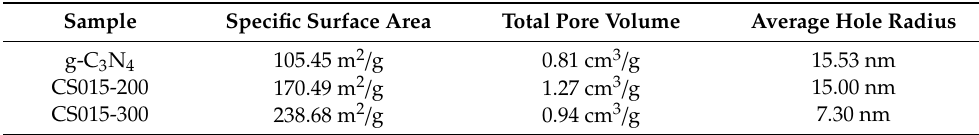
Table 1. The specific surface area, total pore volume, and average hole radius of g-C 3 N 4 , CS015-200 and CS015-300.